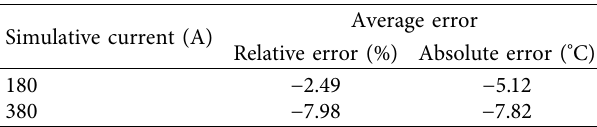
Figure 13: Change curve of cable core temperature and outer sheath surface temperature. Table 2: Calculation error of transient thermal circuit model under various load currents.